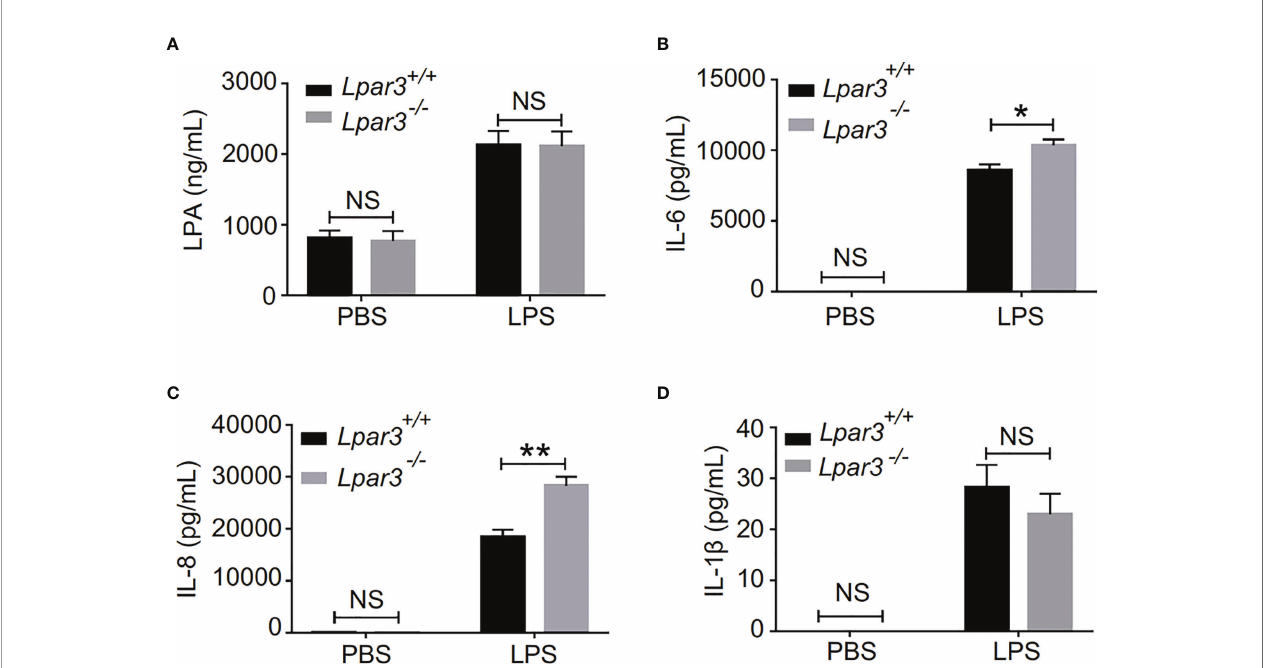
FIGURE 5 | LPA 3 de fi ciency affects the level of IL-6 and IL-8 in the plasma of mice with sepsis. (A), Plasma LPA levels were signi fi cantly increased in LPS-treated mice; however, LPA 3 de fi ciency did not signi fi cantly affect plasma LPA levels in sepsis mice. (n = 12 for each group); (B, C): The plasma levels of the cytokines IL-6, and IL-8 were determined after sepsis induction by LPS, IL-6 and IL-8 in the plasma revealed higher levels in Lpar3 -/- mice with sepsis. (n = 8 for Lpar3 +/+ or Lpar3 -/- control, n = 9 for Lpar3 +/+ LPS, n = 10 for Lpar3 -/- LPS). (D), Plasma IL-1 b levels were no difference in LPS-treated WT and Lpar3 -/- mice. (n = 9 for Lpar3 +/+ or Lpar3 -/- controls, n = 8 for Lpar3 +/+ LPS, n =6 for Lpar3 -/- LPS); *P < 0.05, **P < 0.01. NS, no signi fi cance. LPA 3 , lysophosphatidic acid receptor 3; LPS, lipopolysaccharide; IL-6, interleukin-6; IL-8,